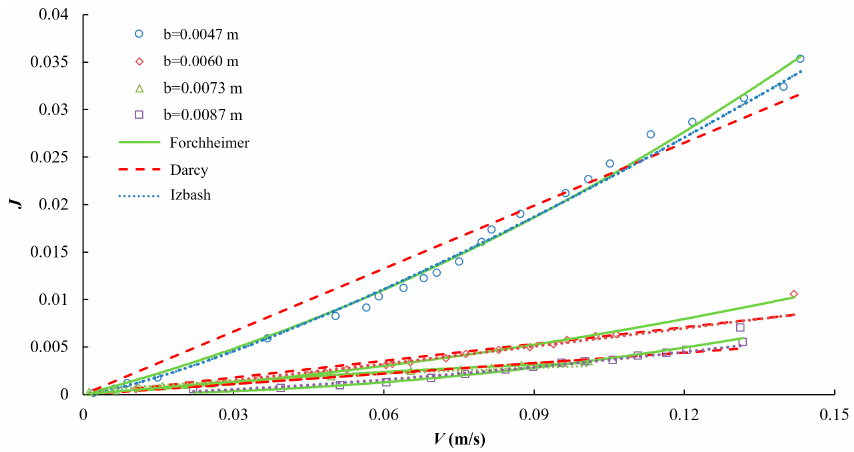
Figure 7. The V – J relationship and fitting results for flow through single fractures with rectangular roughness. Water 2017 , 9 , 656